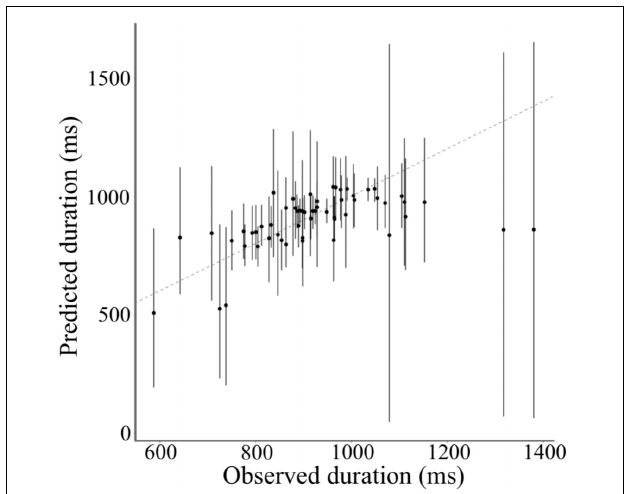
FIGURE 10 | Actual and predicted PSE by the model assuming the weight by reliability. The black dot indicates the mode of the simulation in each subject and condition. The black line indicates 95% HDI. The dotted line indicates the predicted PSE equal to the actual